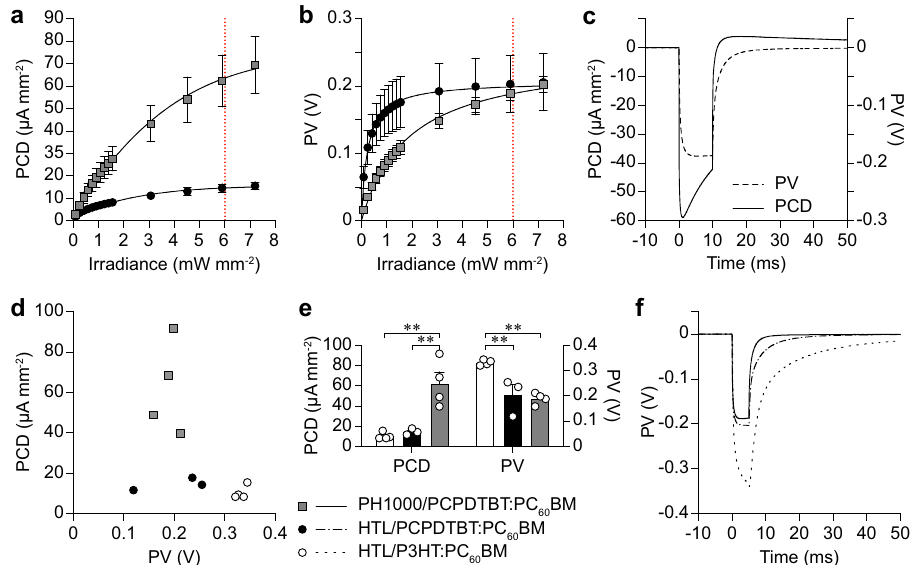
Fig. 3 Optimization of the anodic layer. a , b Mean (±s.e.m.) PCD ( a ) and PV ( b ) obtained at 730 nm for HTL/PCPDTBT:PC 60 BM/Ti (black circles, n = 3 chips) and PH1000/PCPDTBT:PC 60 BM/Ti (grey squares, n = 4 chips). The solid lines are the interpolations with an asymmetrical, fi ve-parameter, logistic dose-response function for PCDs and a hyperbola function for PVs. The vertical red dotted lines represent the normalized irradiance for 730 nm (6 mW mm − 2 ). c , Grand-average PCD (solid line) and PV (dashed line) traces obtained with PH1000/PCPDTBT:PC 60 BM/Ti with 730 nm at the normalized irradiance ( n = 4 chips). d , PV/PCD plot for HTL/P3HT:PC 60 BM/Ti (white circles, n = 4 chips, 565 nm, 1 mWmm − 2 ), HTL/PCPDTBT:PC 60 BM/Ti (black circles, n = 3 chips, 730 nm, 6 mW mm − 2 ), and PH1000/PCPDTBT:PC 60 BM/Ti (grey squares, n = 4 chips, 730 nm, 6 mW mm − 2 ). e Mean (±s.e.m.) PCD and PV obtained with HTL/P3HT:PC 60 BM/Ti (white bars, 10.46 ± 1.72 µ A mm − 2 , 332.5 ± 5.35 mV, n = 4 chips, 565 nm, 1 mW mm − 2 ), HTL/PCPDTBT: PC 60 BM/Ti (black bars, 14.65 ± 1.79 µ A mm -2 , 203.4 ± 42.37 mV, n = 3 chips, 730 nm, 6 mW mm − 2 ), and PH1000/PCPDTBT:PC 60 BM/Ti (grey bars, 62.28 ± 11.54 µ A mm − 2 , 189.6 ± 11.32 mV, n = 4 chips, 730 nm, 6 mW mm − 2 ), respectively, at their normalized irradiance levels. f Comparison of the PV grand-average traces for HTL/P3HT:PC 60 BM/Ti (dotted line, n = 4 chips, 565 nm, 1 mW mm − 2 ), HTL/PCPDTBT:PC 60 BM/Ti (dashed-dotted line, n = 3 chips, 730 nm, 6 mW mm − 2 ), and PH1000/PCPDTBT:PC 60 BM/Ti (solid line, n = 4 chips, 730 nm, 6 mW mm − 2